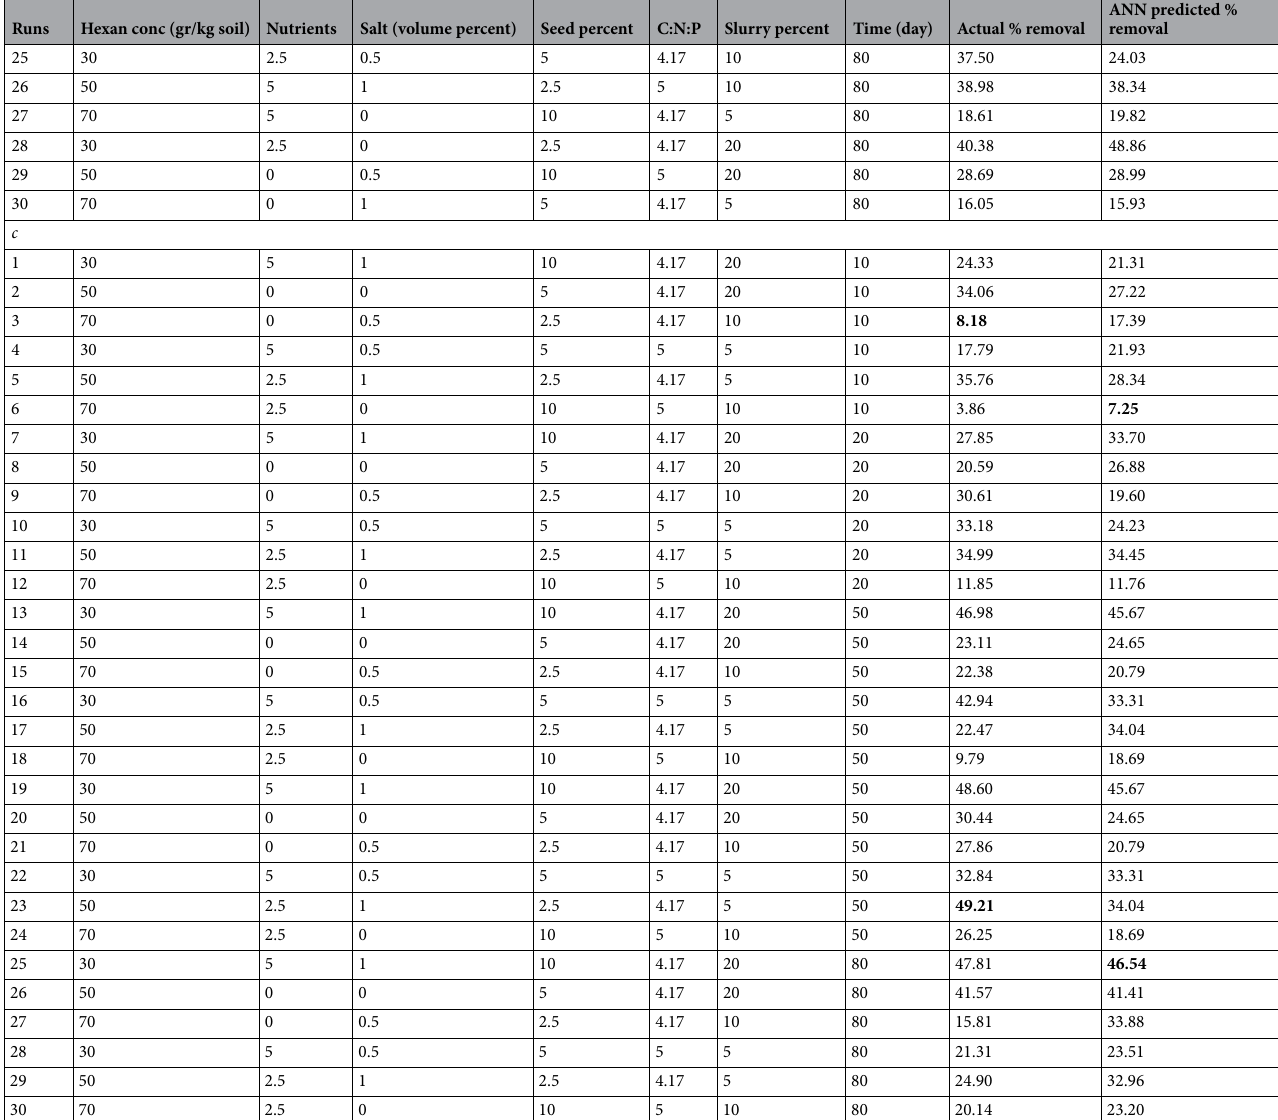
Table 5. The design matrix of independent and dependent variables. a) Acintobacter , b) Acromobacter and c) consortium of Acintobacter and Acromobacter . Significant values are in [bold]. Values are in bold (maximum and minimum response